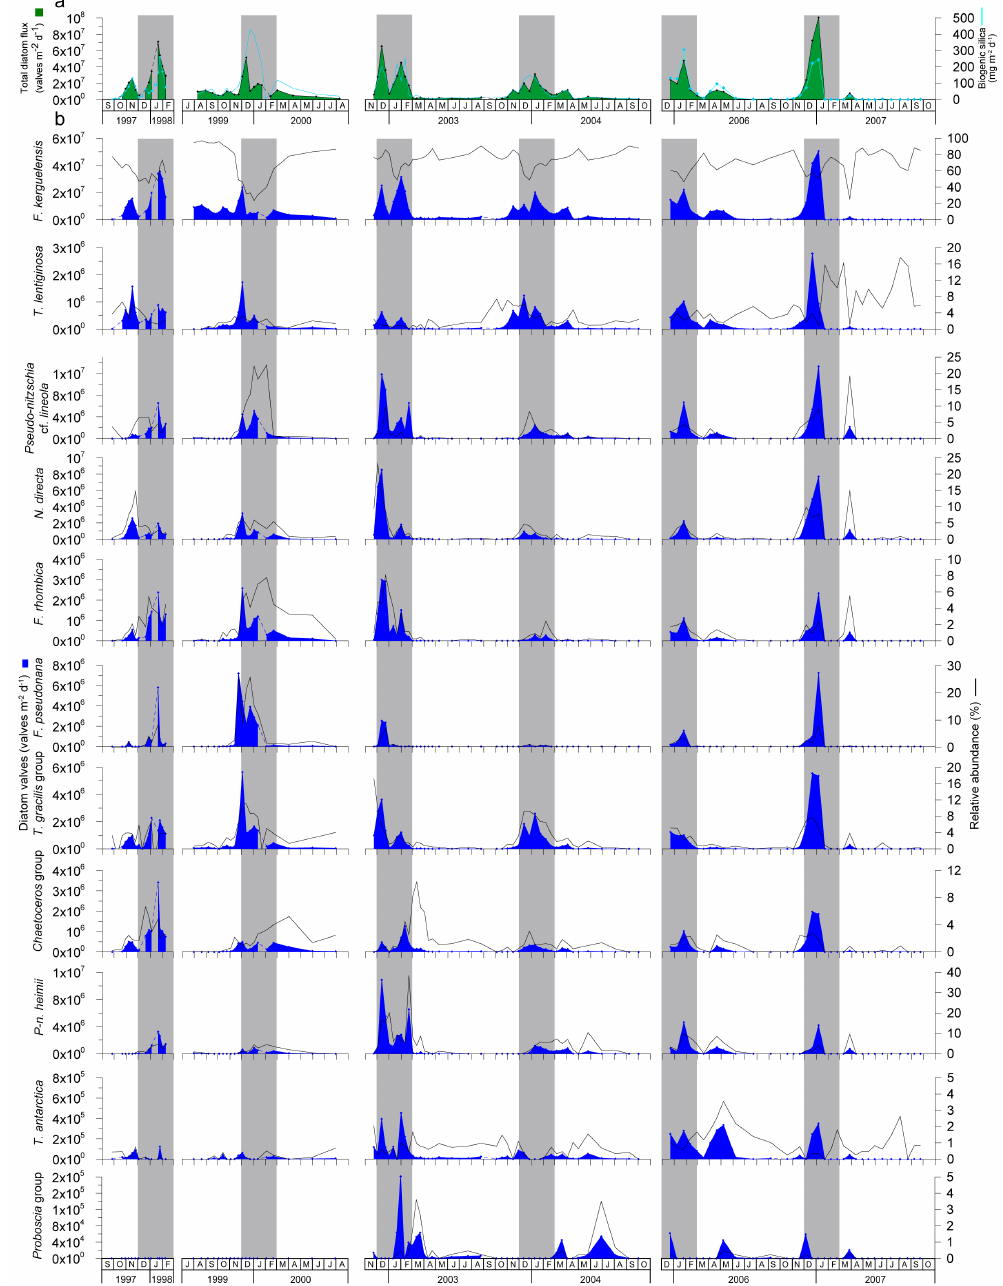
Figure 5. Temporal variability of (a) total diatom flux and biogenic silica and (b) flux and relative contribution of the main diatom species